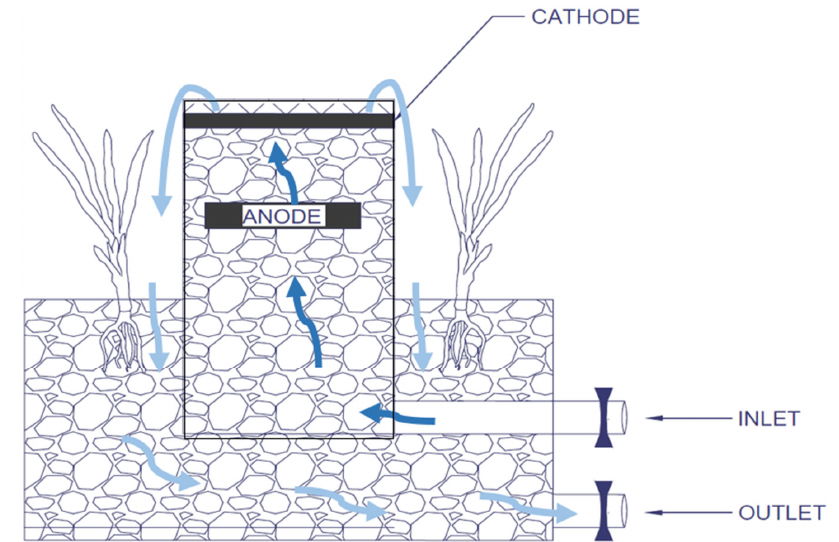
Figure 15. Representation of the stacked CW ‐ MFC ( adapted from Xu et al. (2017) [82]).